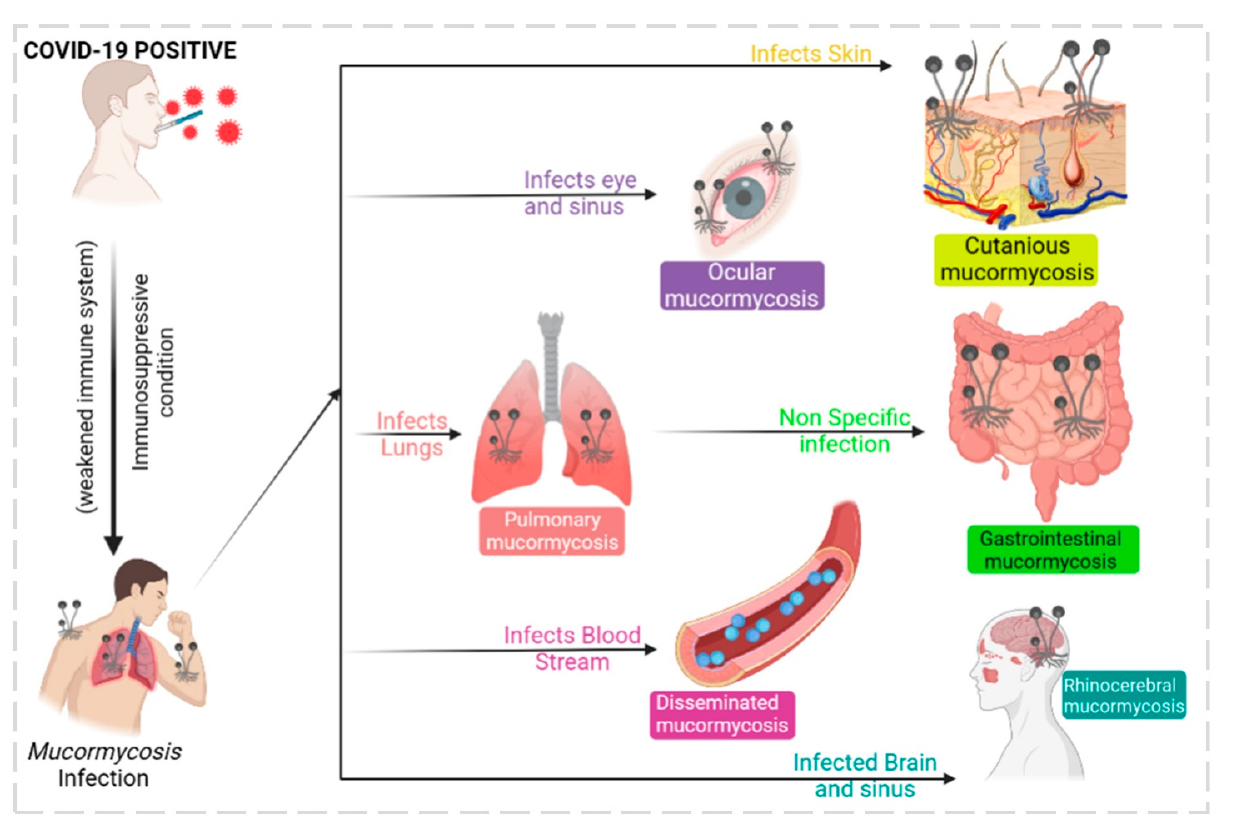
Figure 6. Deep learning-based imaging and detection of mucormycosis infection from images and data. Affected and standard images of rhinocerebral, ocular, cutaneous, pulmonary, and around 30